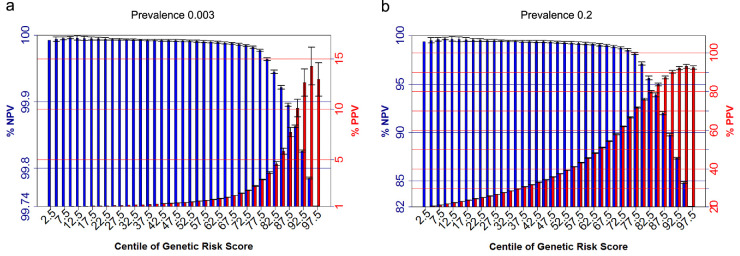
Positive and negative predictive values for patients with AS with AAU for centiles of genetic risk scores. The assumed prevalence of patients with AS with AAU of 0.3% among the population (a), and assumed prevalence of 20% in outpatient clinics (b). Error Bars denote 2 standard deviations based on 10-fold cross validation.